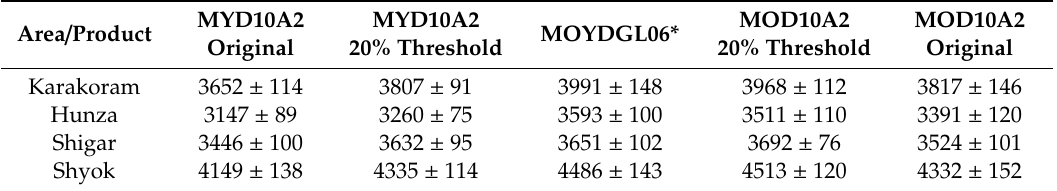
Table 4. Mean and standard deviation of annual average SLA (m a.s.l.) for the Karakoram region. MYD10A2 Area / Product